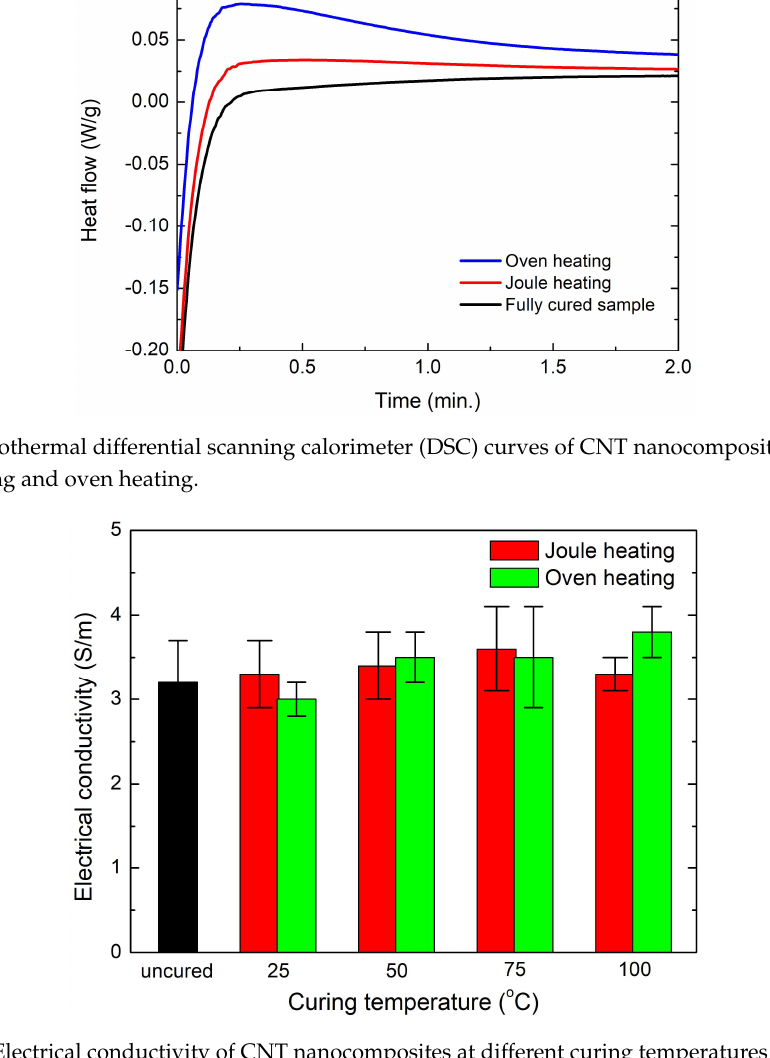
Figure 10. Electrical conductivity of CNT nanocomposites at different curing temperatures, comparing Joule heating and conventional oven heating.